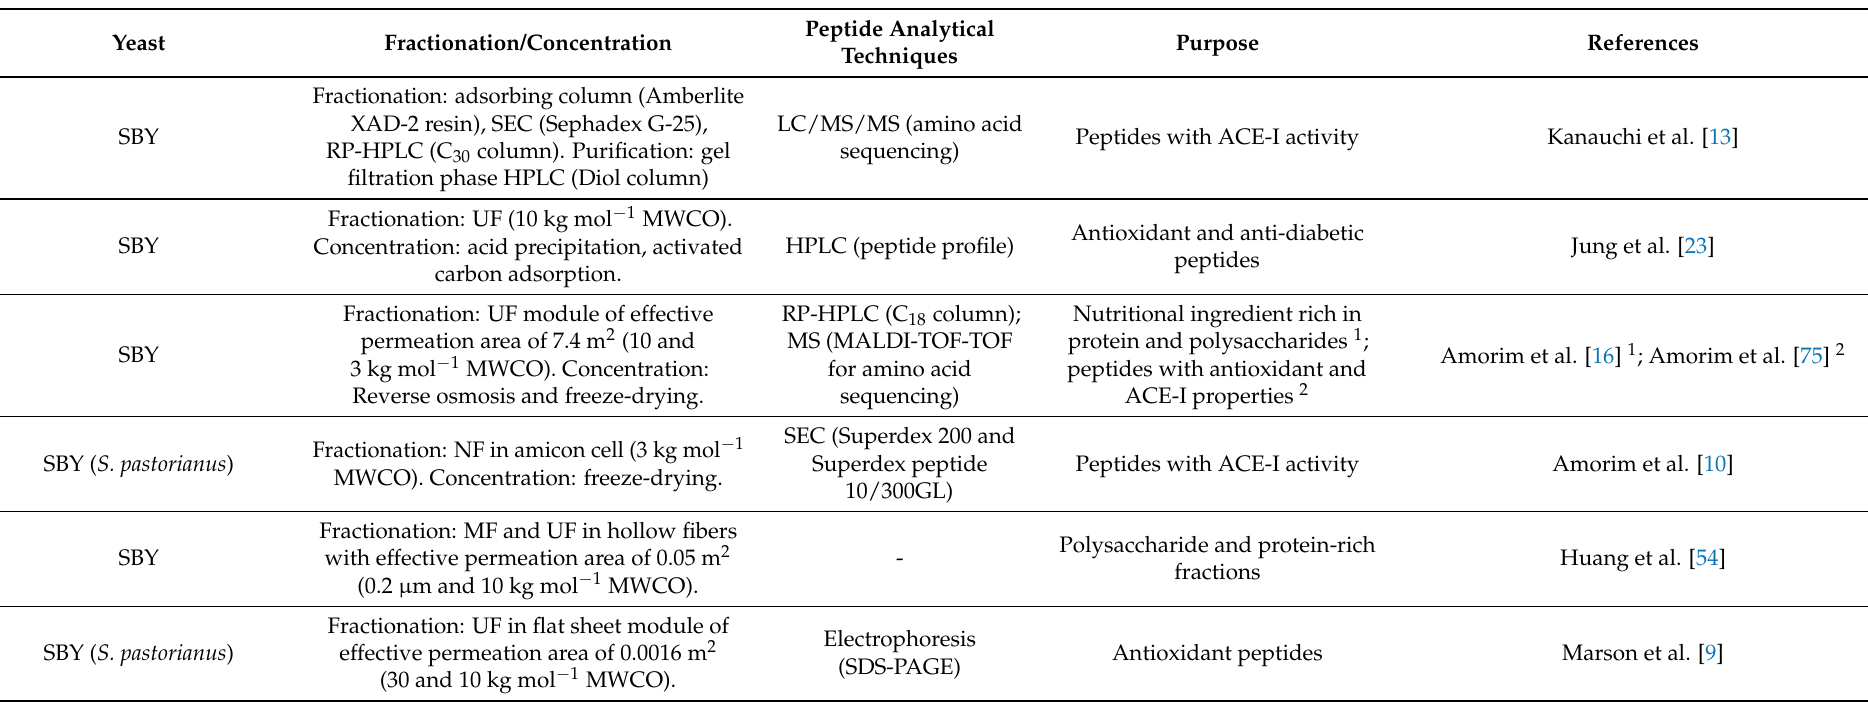
Table 3. Fractionation of protein hydrolysates from spent yeasts from brewing by membrane technologies and/or chromatography in the obtention of bioactive